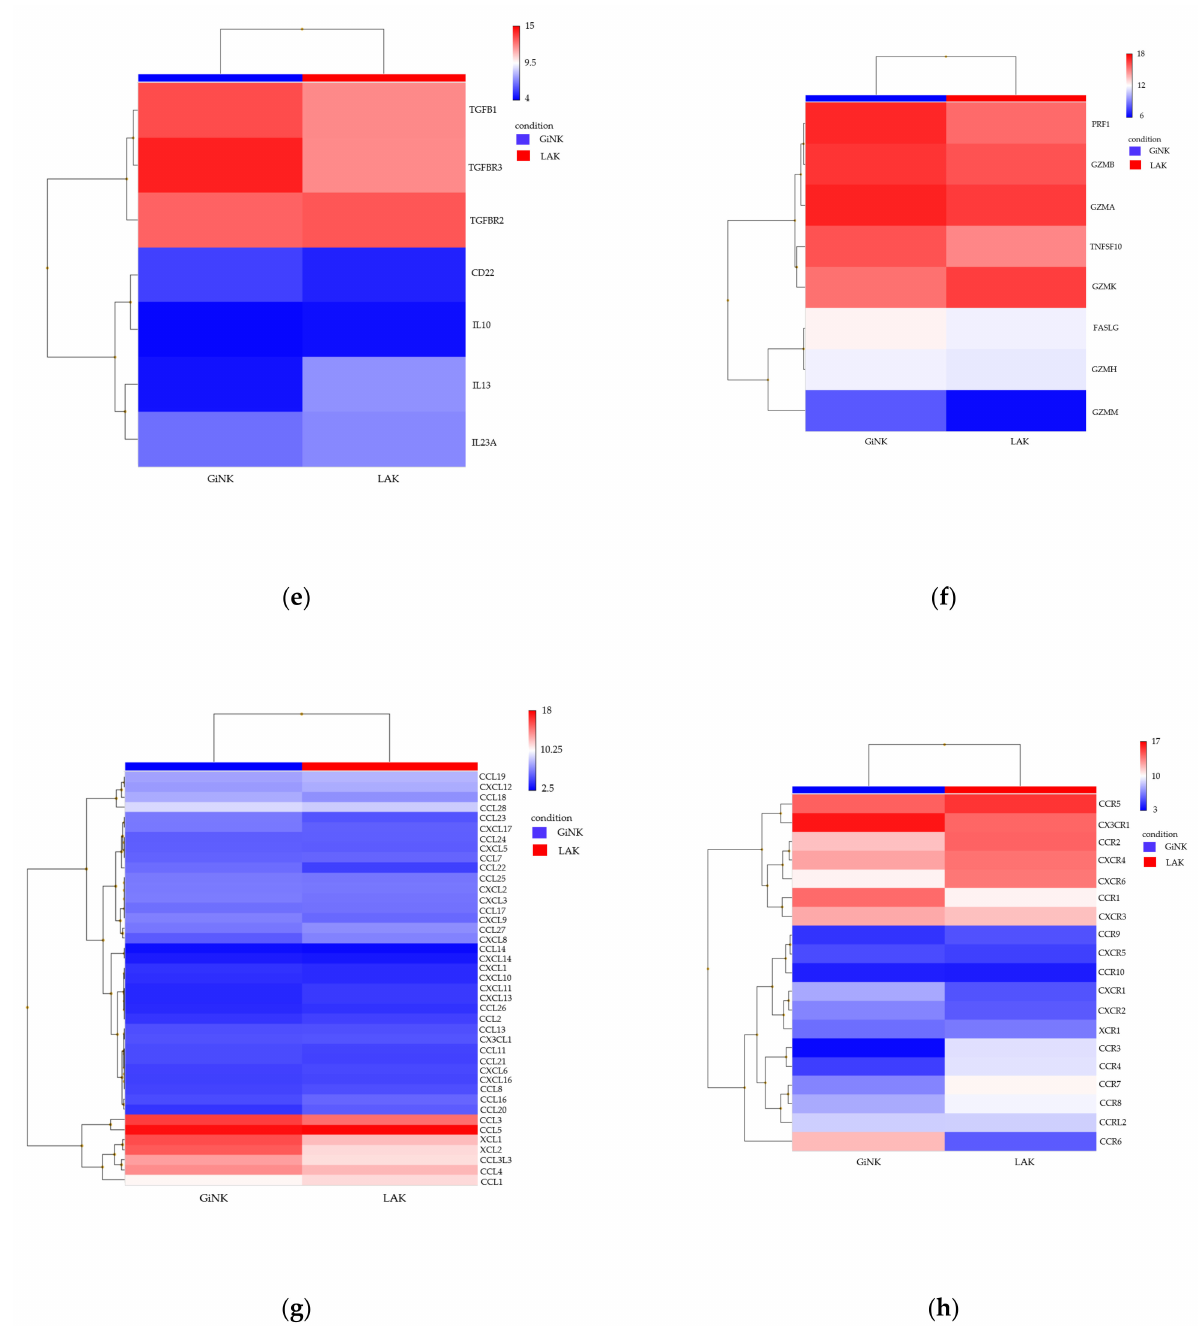
Figure 5. Scatter plot and heatmaps of transcriptome-wide Clariom™ S array of genuine induced NK cells (GiNK) and lymphocyte-activated killer (LAK) cells. ( a ) The scatter plot represents the gene expression of the NK cells and LAK cells (red plot, NK cells; green plot, LAK cells). ( b – h ) Heatmaps represent gene expression related to NK cell activation receptors ( b ), NK cell inhibitory receptors ( c ), immune activation ( d ), immune suppression ( e ), cytotoxicity ( f ), chemokines ( g ), and chemokine receptors ( h